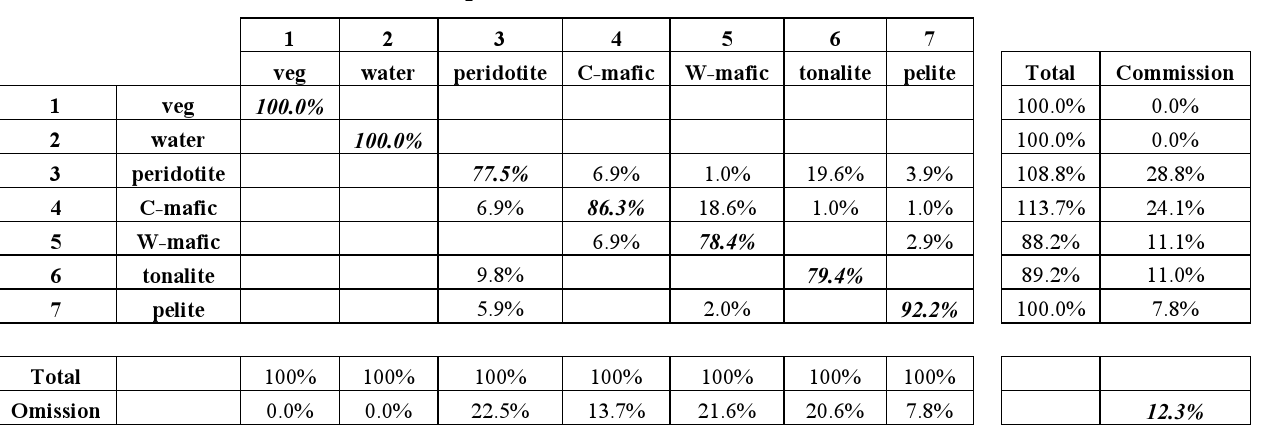
Table 2. Confusion matrix for the neural network classification of Landsat TM data. The overall agreement measure is 0.877 (87.7%), and the corresponding Kappa value is 0.8562. Labels for mafic classes are abbreviated: “C-mafic” refers to Chukotat Group mafics and “W-mafic” refers to Watts Group